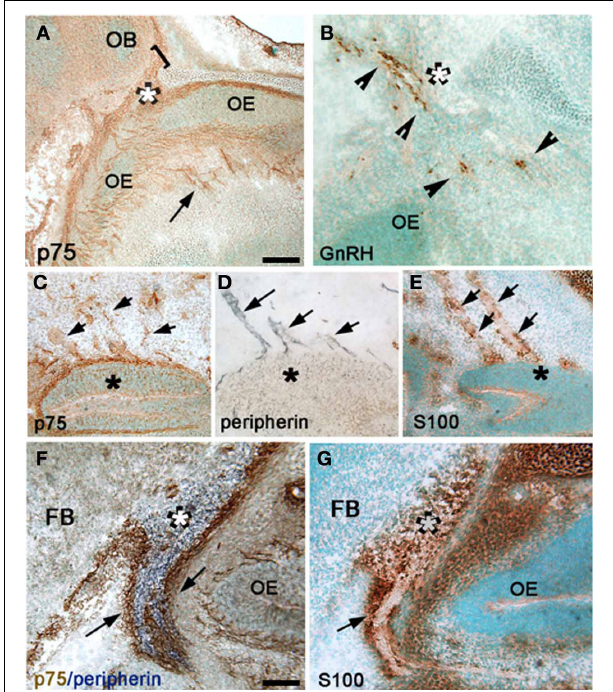
FIGURE 2 | P75NGFR cells are associated with the developing olfactory system—OECs. (A,B) Comparison of p75NGFR staining ( A , p75) and GnRH staining (B) indicated that more structures express p75NGFR than just the GnRH cells. p75NGFR staining (A) highlighted track-like structures in the nose (arrow) around the OE and crossing through the nasal mesenchyme, as well as at the nasal/forebrain junction (white asterisk) extending into the developing olfactory bulb (OB, bracket). At this development stage, GnRH neurons ( B , arrowheads) cross the nasal/forebrain junction (white asterisk) and turn caudal into the FB. (C–E) Sagittal sections of the nasal region stained for p75NGFR (C) , peripherin (D), and S100 (E) indicate that both p75NGFR- and S100-positive elements are distributed along olfactory axons (expressing peripherin) extending from the VNO (asterisk). At this developmental stage S100 is a marker for OECs. (F) Double immunocytochemistry for p75NGFR (brown) and peripherin (blue) revealed p75NGFR immunopositive cells (arrows) at the nasal forebrain junction (white asterisk) that apposed peripherin positive olfactory axons (blue). Note p75NGFR and peripherin did not colocalize in olfactory fibers. (G) Serial consecutive section to that in (F) , immunostained for S100 (brown, arrow) showing robust labeling in a pattern similar to that of p75NGFR (compare F and G ). Scale bars: (A–E) = 250 μ m; ( F,G) = 50 μ m.